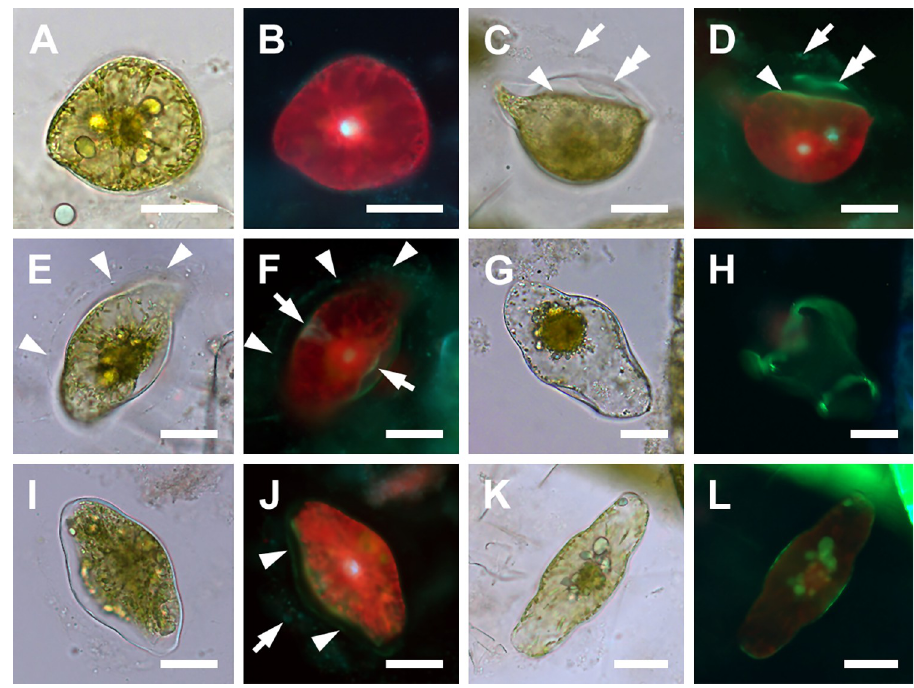
Fig 4. Immature isodiametric auxospores (brightfield and DAPI/PDMPO epifluorescence light microscopy). (A, B) Early isodiametric auxospore showing beginning of first apical bud expansion and faint halo of earlier deposited silica around periphery. (C, D) Girdle view of auxospore with a hemispherical ventral (bottom) side and flattened dorsal (upper) side. Note different size of “apical buds” and three layers of green fluorophore in D indicating successive layers of silica deposition. The oldest represents incunabula (arrow), the next below either a more strongly silicified incunabula or a part of the outer epizonium (double arrowhead), and the layer resting on the cell surface represents remaining epizonium (arrowhead). (E, F) Older auxospore enveloped in translucent incunabula (arrowheads) with some of the later deposited silica best seen above retracting protoplast on the dorsal (right) side. The band circling the mid-cell (arrows in F) likely represents the primary band of TP. (G, H) Aborted and disintegrating auxospore with two PDMPO-labeled open and aligned but not meeting bands of the TP. (I, J) Anisodiametric auxospore with green multilayered wall components, (arrowheads and arrow). (K, L) An oblong auxospore showing concurrent apical and mid-cell areas of silicification. All scale bars: 50 μ m.